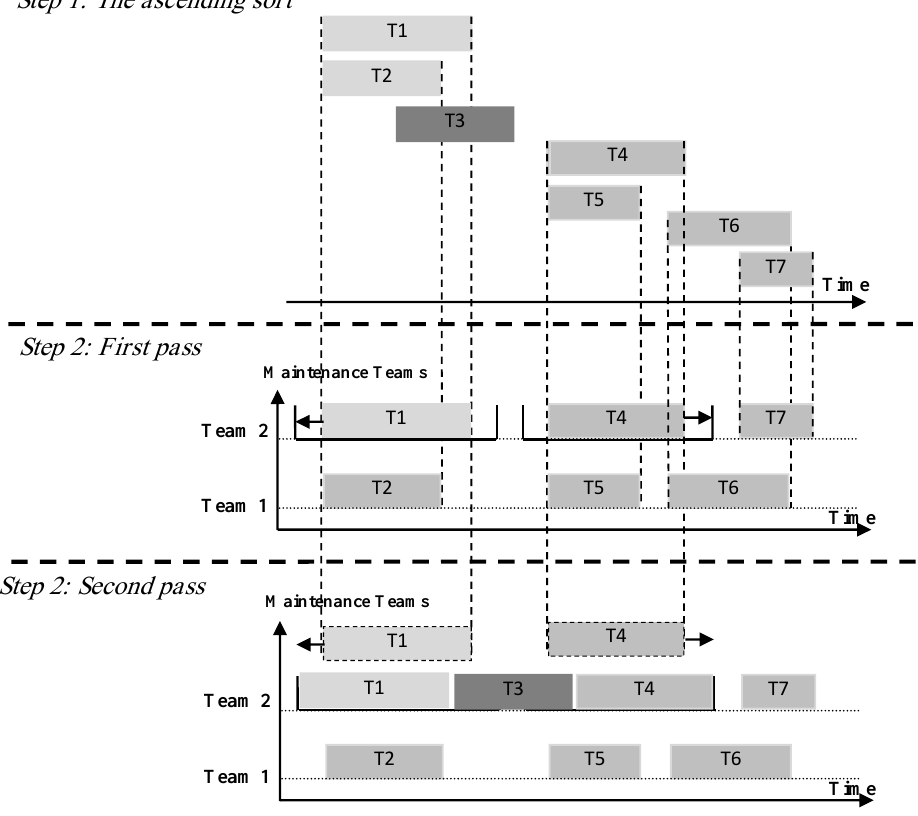
Fig. 4. Static scheduling heuristic: an